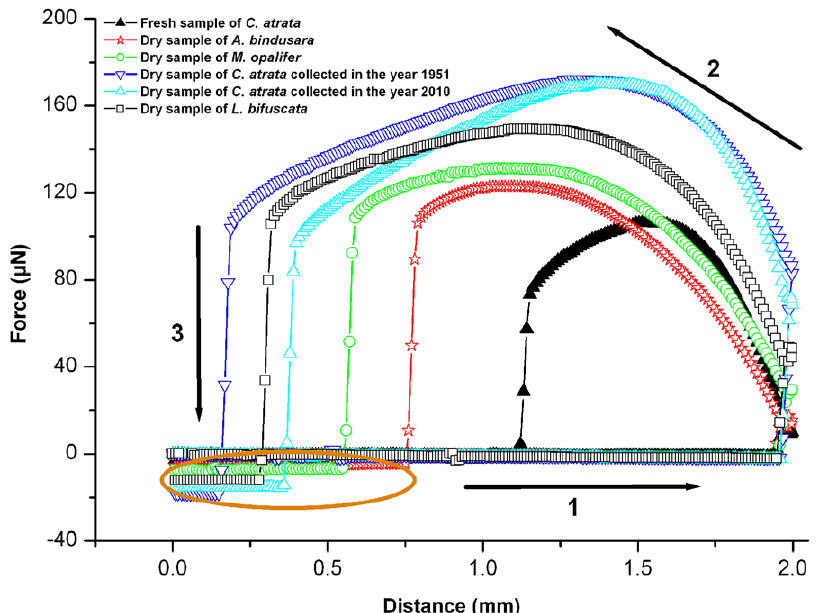
Figure 3. Force-distance curves recorded before and after the water droplet makes contact with the cicada wing. Process 1: the cicada wing surface approaches the water droplet. Process 2: the cicada wing surface leaves the water droplet after contact. Process 3: the cicada wing surface breaks away from the water droplet. The negative values in the circled section indicate an amount of water still remaining on the wing surfaces when separating from each other.